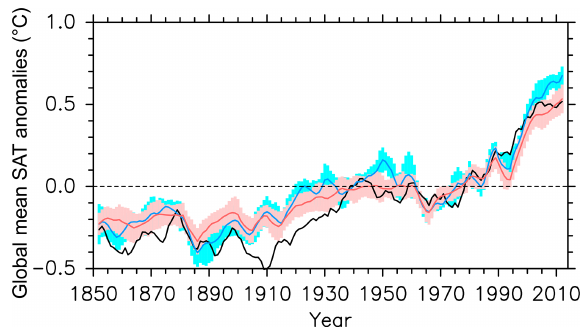
Figure 32. Time series of the global mean SAT anomalies for ob- servations (black), MIROC6 (red), and MIROC5 (blue). A 5-year running-mean filter is applied to the anomalies with respect to the 1961–1990 mean. Colors indicate spreads of ensemble experiments for each model (1 standard